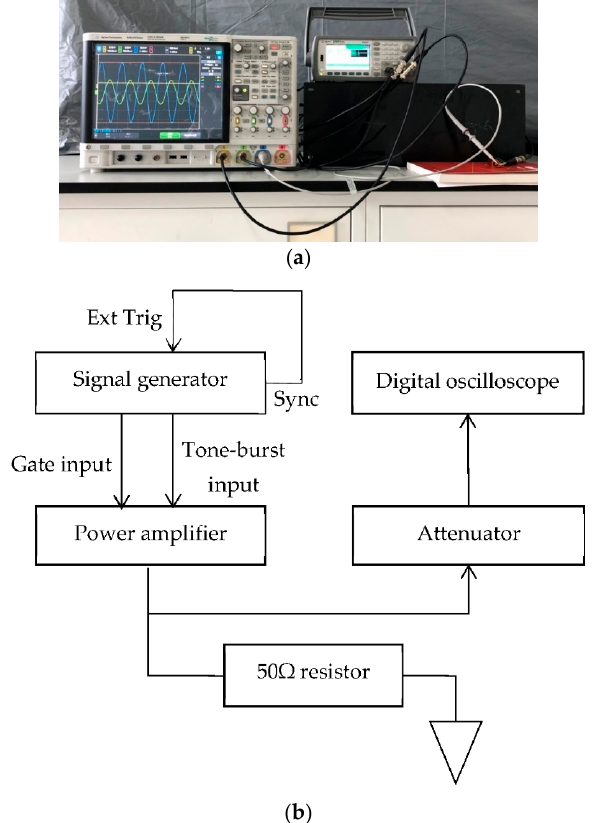
Figure 5. ( a ) Photo and ( b ) schematic of the measurement system to evaluate the performance of the proposed linear